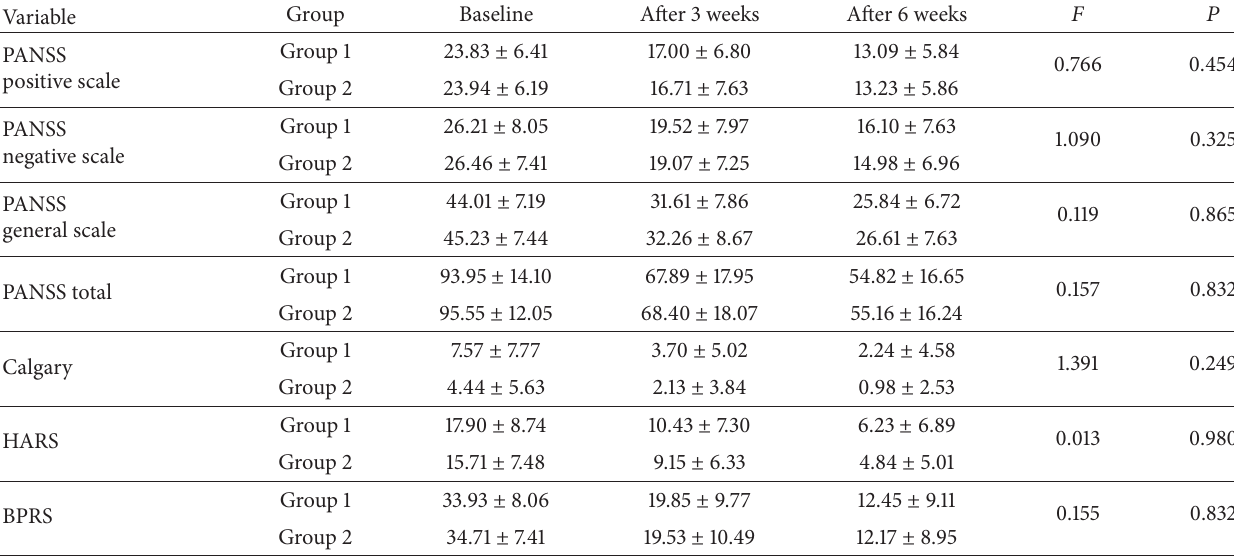
Table 5: Resolution of symptom in schizophrenia patients with substance abuse (Group 1, 𝑛 = 91 ) and without substance abuse (Group 2, 𝑛 = 52 ): general linear model repeat measure ANOVA.